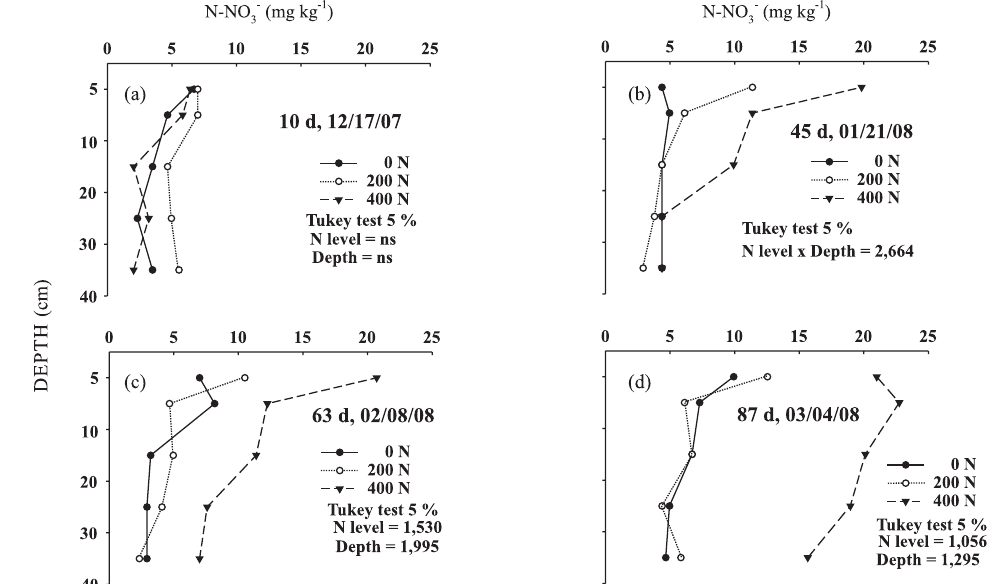
Figure 2. Soil N-NO 3- levels in relation to different N rates (0, 200 and 400 kg ha -1 N) in the soil profile (depth 40 cm) under Alexandergrass ( Brachiaria plantaginea